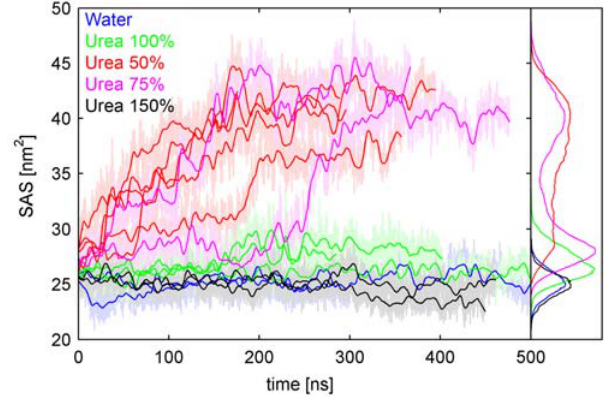
Figure 3. Solvent accessible surface area of the protein in all simulations. Blue: water, orange: urea 50% , magenta: urea 75% , green: urea 100% , black: urea 150% . The lines show traces smoothed by a running average over 500 ps. The histogram in the right panel shows the frequency of the respective SAS.